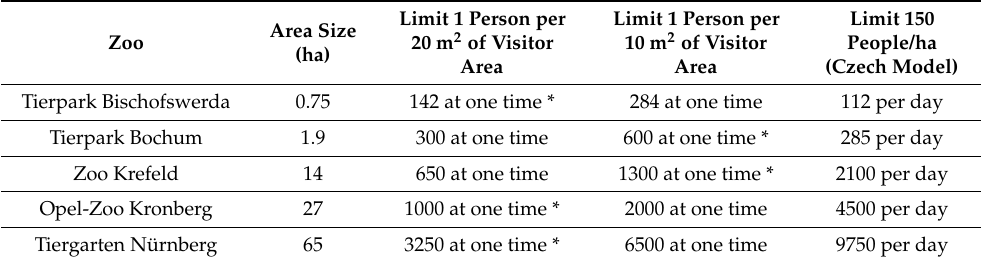
Table 4. Examples of German Zoos that Approached the Limitation of the Number on Visitor Numbers Differently, May 2020 (* the real